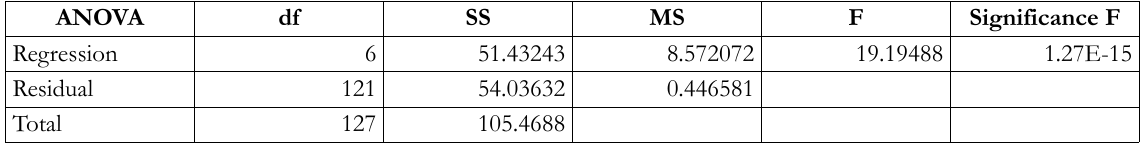
Table 17. Analysis of variance for Support services against increased usage of